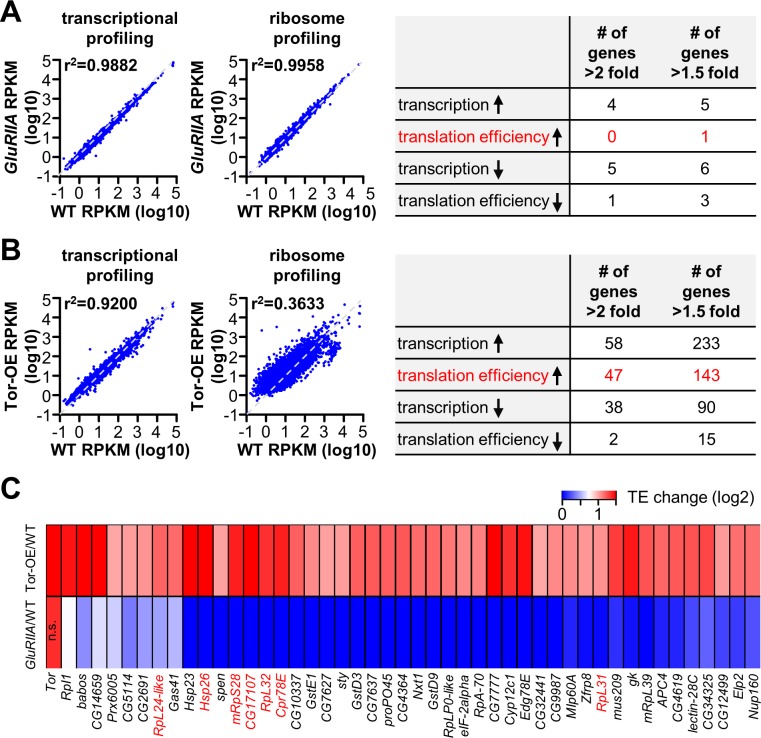
Few changes in postsynaptic transcription or translation are observed in GluRIIA mutants.(A) Plot of transcriptional and translational expression levels of all genes in GluRIIA mutants (w1118;GluRIIASP16; BG57-Gal4/UAS-RpL3-3xflag) compared to wild type (w1118; BG57-Gal4/UAS-RpL3-3xflag), with near perfect correlations observed (indicated by r2 values). Right: Table showing the number of genes with significantly up-regulated (up arrow) or down-regulated (down arrow) transcription or translation efficiency (TE) in GluRIIA compared to wild type using the indicated cut off values. (B) Plot of transcriptional and translational expression levels of all genes in Tor-OE (w1118;UAS-Tor-myc/+;BG57-Gal4/ UAS-RpL3-3xflag) compared to wild type. Note that while moderate changes in transcription are observed, large differences in translation are found (indicated by r2 values). Right: Table showing the number of genes with significantly up-regulated (up arrow) or down-regulated (down arrow) transcription or TE in Tor-OE compared to wild type using the indicated cut off values. (C) Heat map indicating the 47 genes with significant increase in TE in Tor-OE, with the corresponding genes in GluRIIA mutants shown below. Note that no trend is observed in translational expression of these genes in GluRIIA mutants. TOP mRNAs are highlighted in red. Additional details can be found in S5 and S6 Tables.